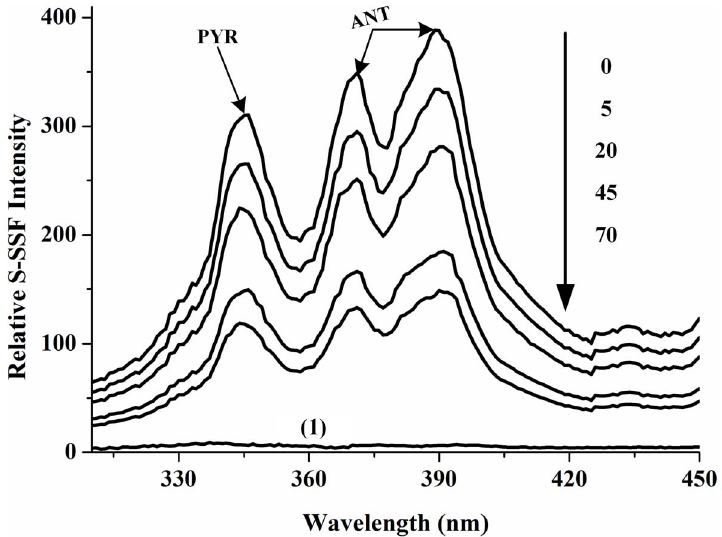
Figure 2. Synchronous fluorescence spectra of PYR and ANT adsorbed onto the leaves of Ko in multicomponent mixtures ( Dl =38 nm), measured at different times during irradiation. The order of the changes in fluorescence intensity over time (at 0 min, 5 min, 20 min, 45 min and 70 min) is indicated by the arrow. Wavelengths of 390 nm and 346 nm were selected for ANT and PYR, respectively. (1): Synchronous fluorescence spectra of the uncontaminated Ko